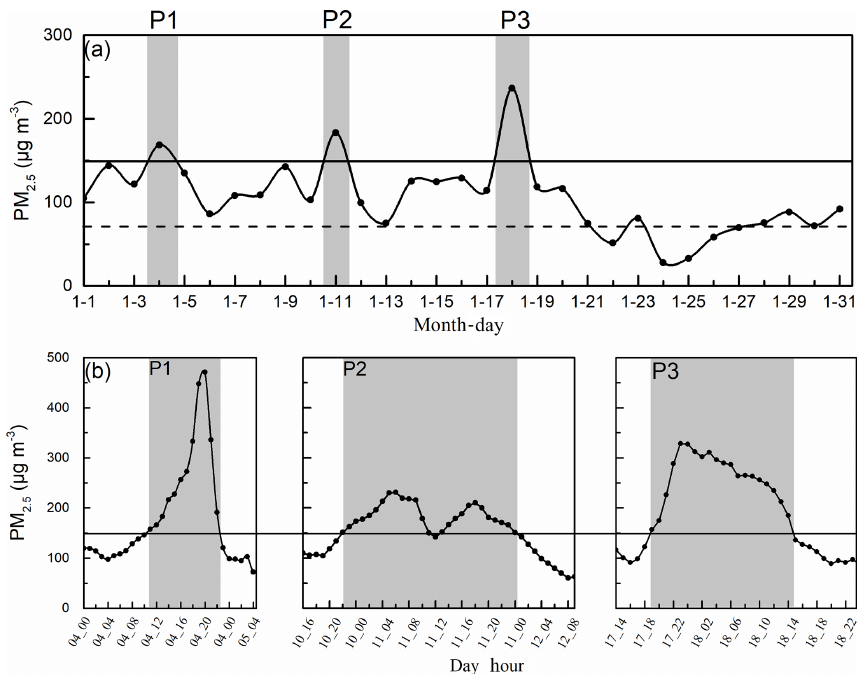
Figure 3. (a) Daily changes in surface PM 2 . 5 concentrations in Wuhan in January 2016 with PM 2 . 5 concentrations exceeding 75µgm − 3 (dashed line) and 150µgm − 3 (solid lines) for light and heavy haze pollution, respectively. (b) The hourly variations in surface PM 2 . 5 concentrations in three heavy air pollution events, P1, P2, and P3, with excessive PM 2 . 5 levels ( > 150µgm − 3 ) marked by the shaded